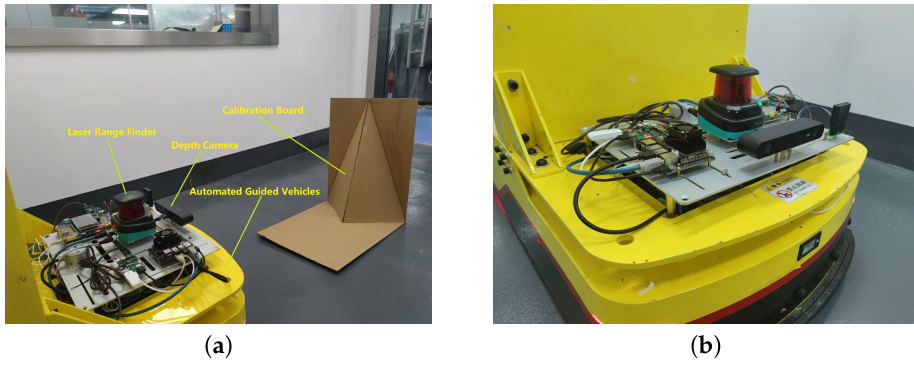
Figure 5. Experimental equipment and sensor installation location. ( a ) Experimental equipment. ( b ) Relationship of sensor mounting